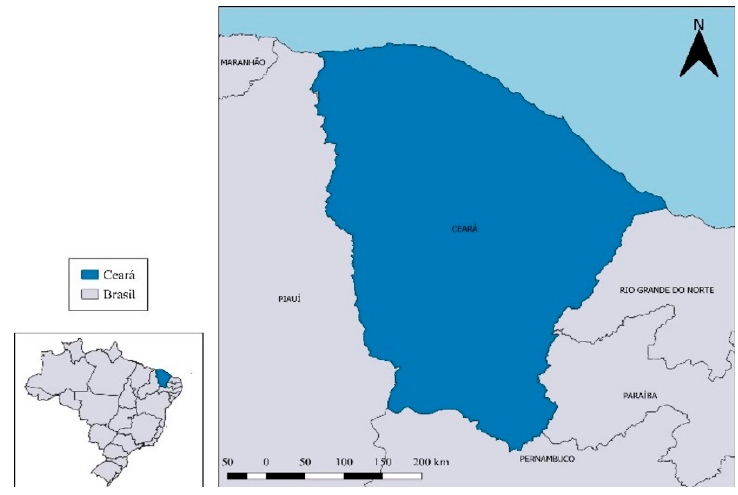
Figure 1. Location of the State of Ceará.